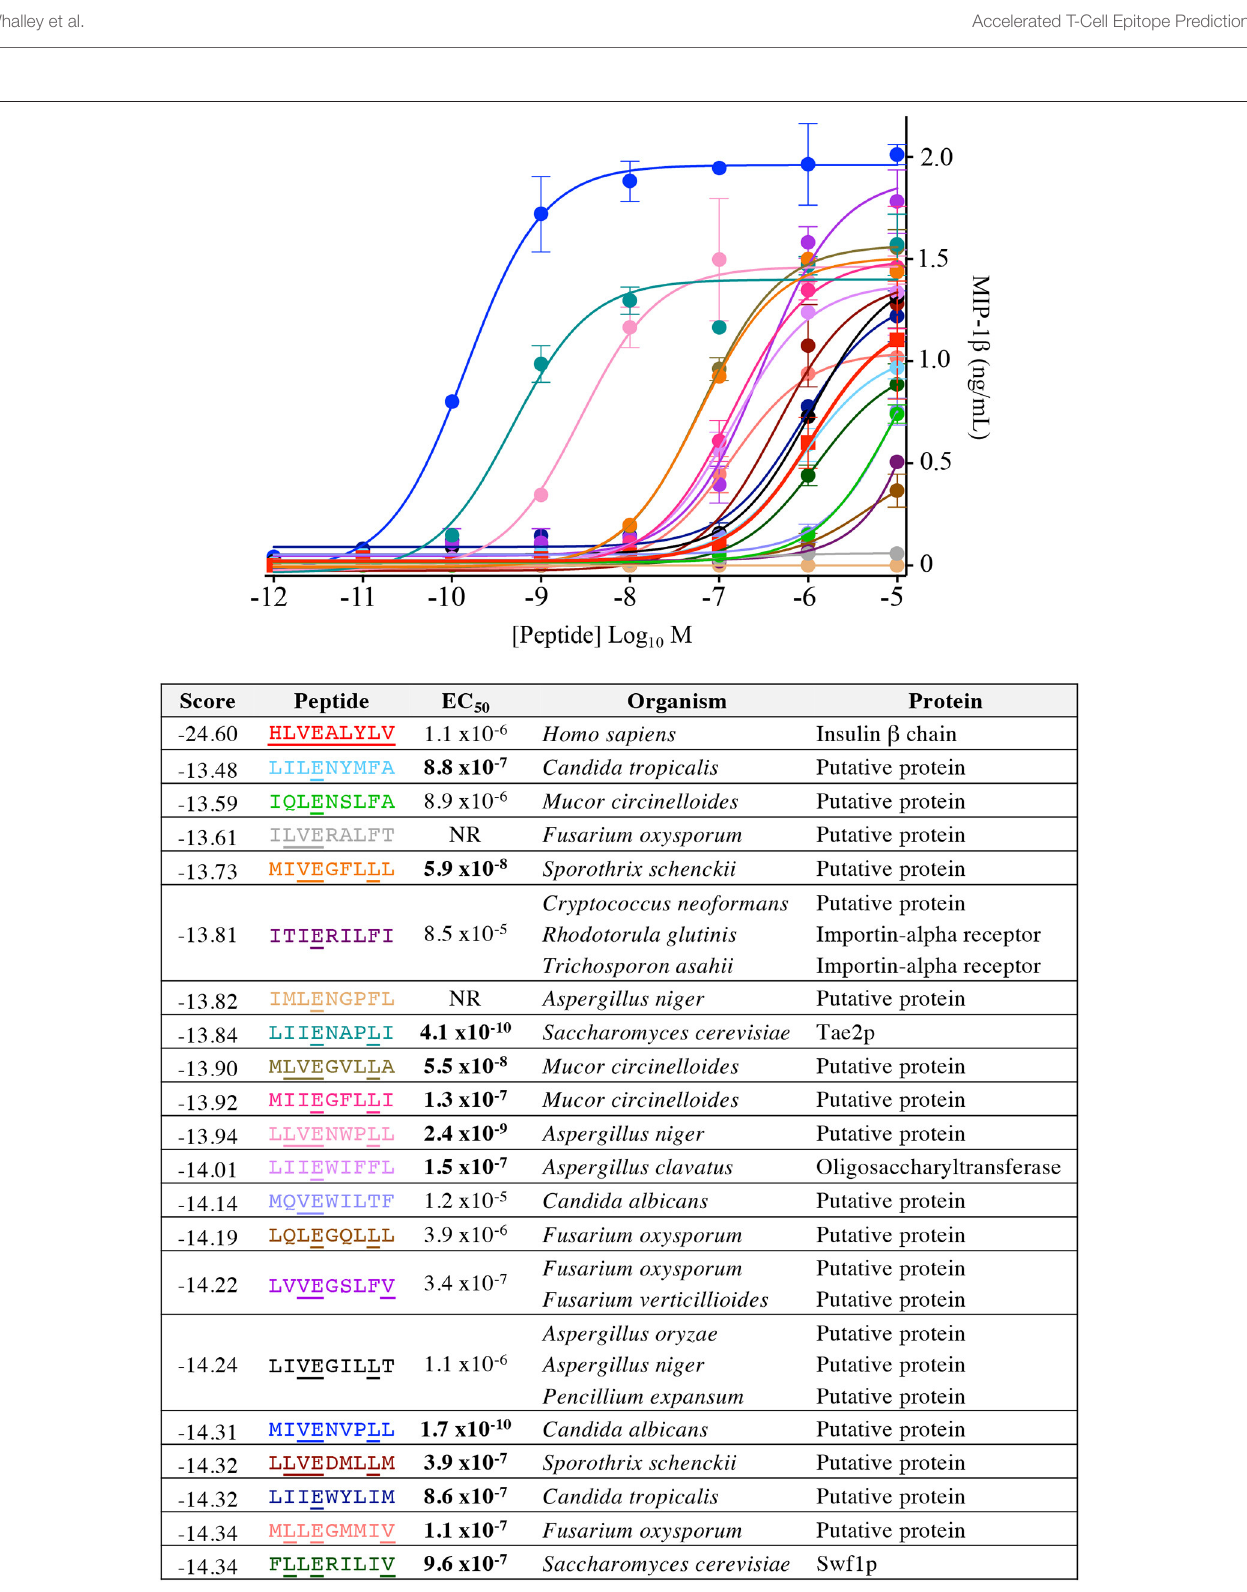
Frontiers in Immunology | www.frontiersin.org